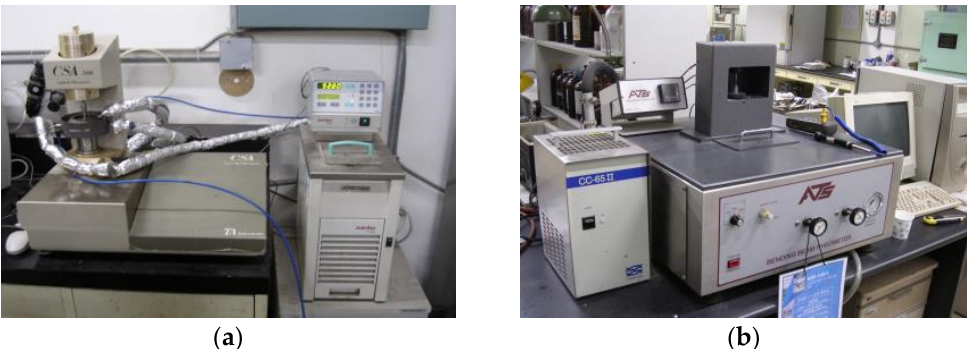
Figure 2. Image of performance grade test by: ( a ) dynamic shear rheometer, and ( b ) bending beam rheometer.